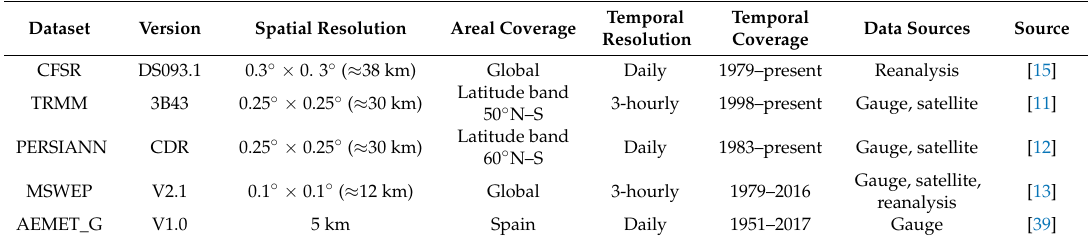
Table 2. List of datasets used in this study and coverage periods.